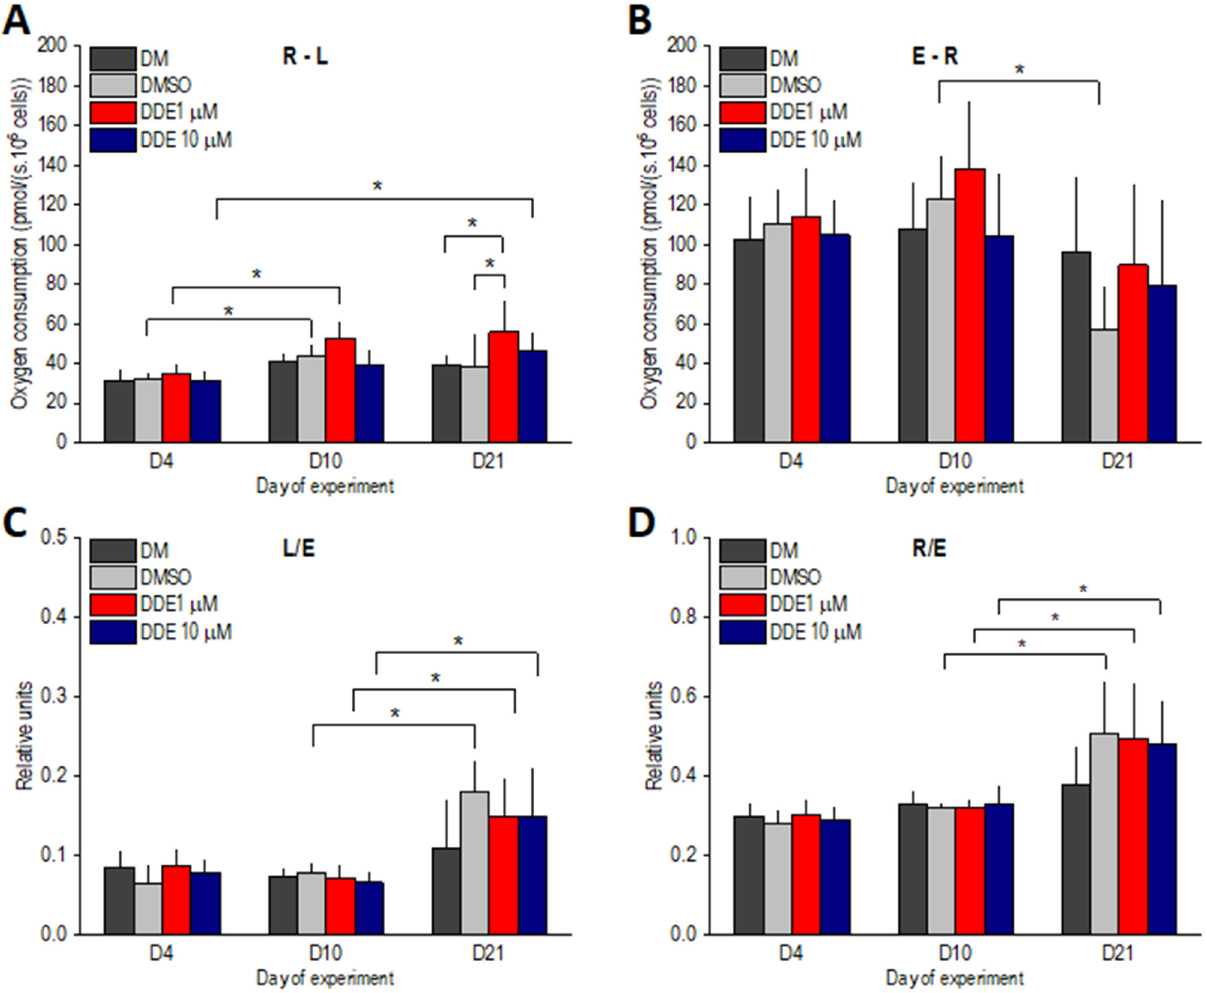
Figure 6. ( A , B ) ATP-related oxygen consumption (R-L) and reserve ETS capacity (E-R) in adipocytes differentiating in media containing no additive (DM) or DMSO, DMSO and 1 μ M p,p’-DDE, and DMSO and 10 μ M p,p’-DDE on days 4, 10, and 21 of the experiment. ( C , D ) Flux control ratios L/E and R/E. Significant differences * p < 0.05 (Friedman and Wilcoxon rank sum tests).